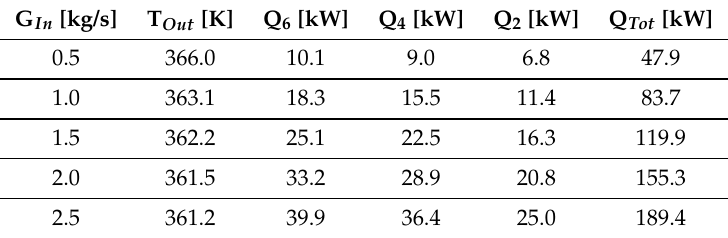
Figure 11. Outflow temperature and transferred heat flux for the new geometry. ( a ) Mass-averaged outflow temperature as a function of G In for T Cyls = 440 K. ( b ) Cylinder specific and total transferred heat flux as a function of inlet mass-flow rate for T Cyls = 440 K. ( c ) Comparison of the mass-averaged outflow temperature as a function of G In and T Cyls between the old and the new single-inlet geometry. ( d ) Total transferred heat flux as a function of the inlet mass-flow rate obtained with the old and the new geometry. Table 5. Mass-averaged temperature, cylinder-specific and total transferred heat flux for T Cyls = 440 K and G In = 0.5, 1.0, 1.5, 2.0, and 2.5 kg/s when considering the new geometry.